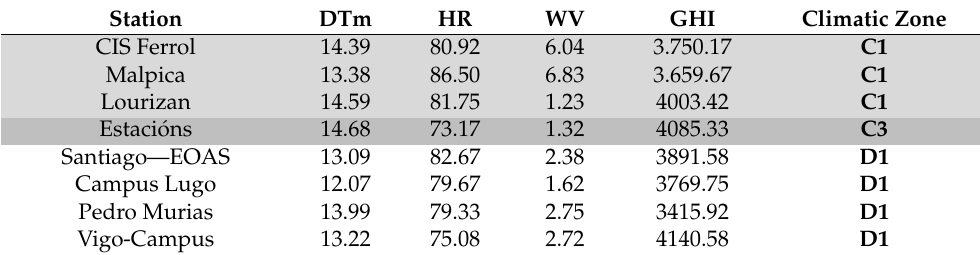
Table 12. Comparative table of annual mean values for the 8 stations (period 2008–2017).